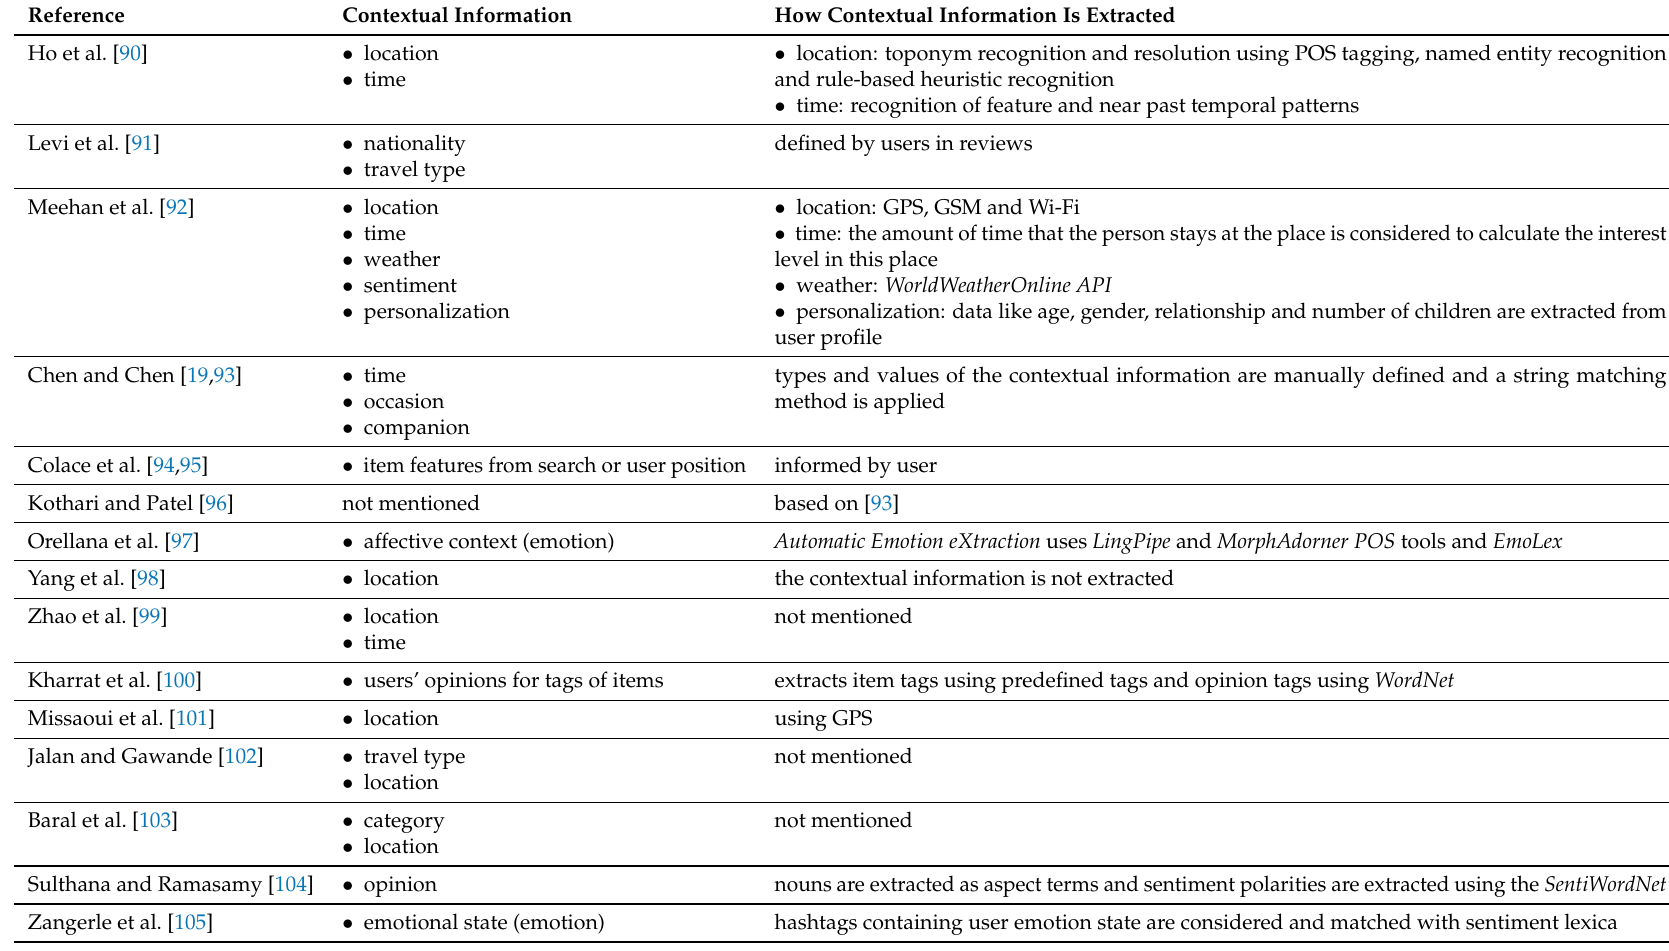
Table 2. Answers for research questions related to contextual information (questions 1 and